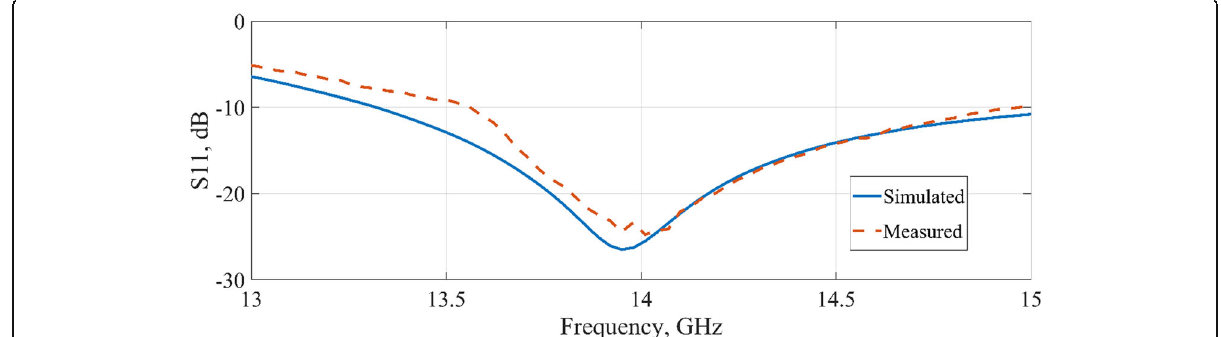
Fig. 22 Simulated and measured S 11 behaviour of the antenna element operating from 13.5 GHz to 15 GHz for 10-dB return